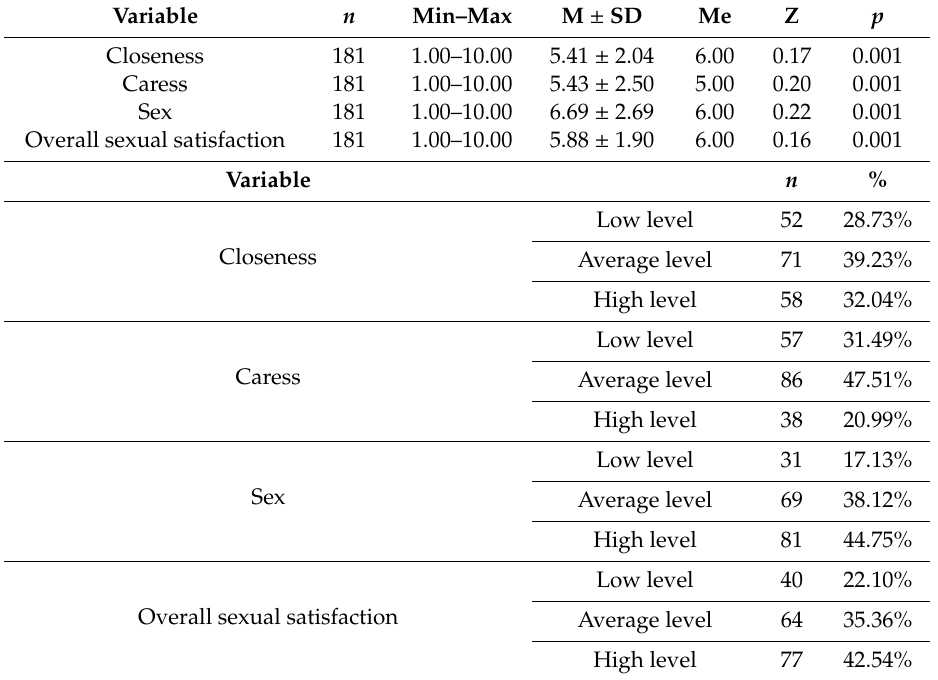
Table 5. Sexual satisfaction of the pregnant